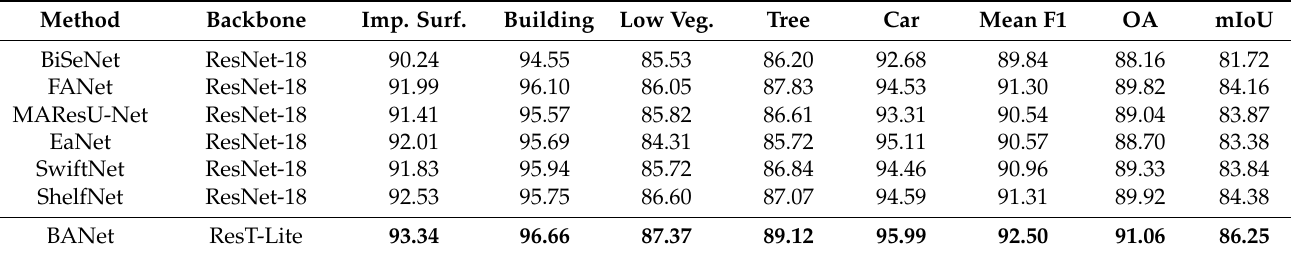
Table 2. The experimental results on the Potsdam